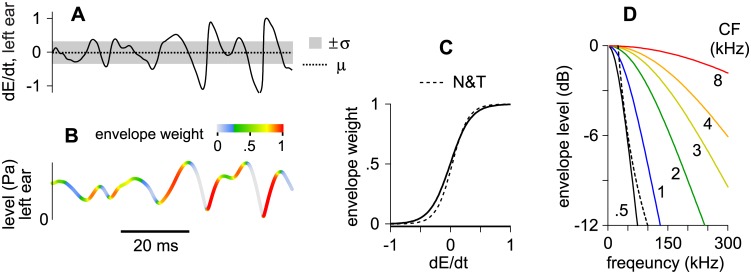
Demonstration of how envelope weights were obtained from band-filtered noise-pairs.
(A) Envelope derivatives measured from the envelope of the signal in the left ear. A horizontal dashed line shows the mean derivative (μ) whereas gray shading shows ±1 standard deviation (±σ). (B) Envelope of the signal in the left ear from which the derivatives were measured. Shading shows the weights that were attributed to the signal using Eq 1. (C) Weights calculated using Eq 1 (solid line) for a continuous range of dE/dt values (abscissa). The dashed line shows normalized weights derived for the barn owl from the responses of space-map neurons to the derivatives of deeply amplitude-modulated noise bursts. (D) Spectra obtained from the envelopes of band-filtered noises (0.5–8 kHz; solid lines). A single dashed line, resembling the 500 Hz band, shows the average spectrum of the low-pass envelopes that were examined by Nelson and Takahashi [27, 36]. Note that weights used in the owl study (dashed line in C) are similar to those at 500 Hz (solid line in C) because their envelope spectra (D) are similar.